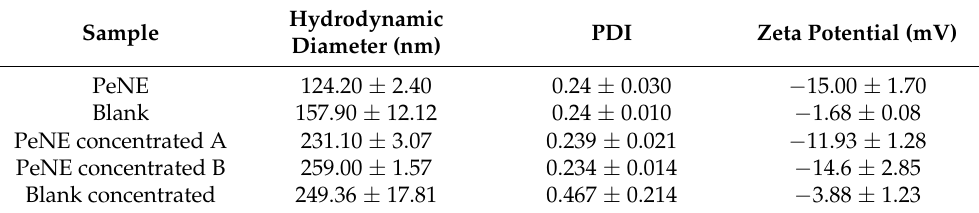
Table 1. Physicochemical characteristics of the PeNE formulations. The results are reported as the average of three independent measurements ( n = 3 ±